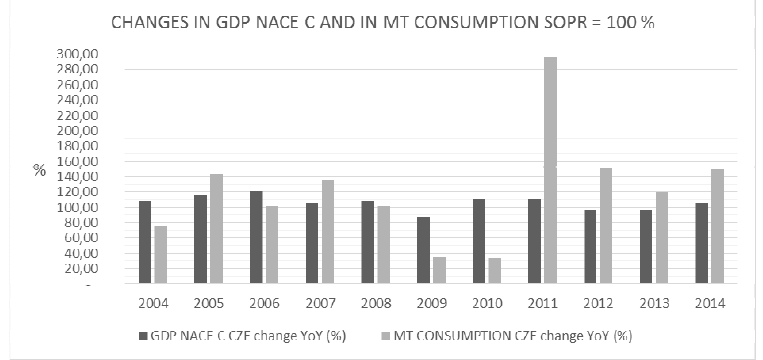
Fig. 6 - Annual changes in industrial production GDP NACE C and consumption MT in the Czech Republic from 2004 to 2014, constant prices. Source: CZSO, (2017) . Association of Engineering Technology: Reports on the state of Machine Tools Branch in the Czech Republic 2007 -